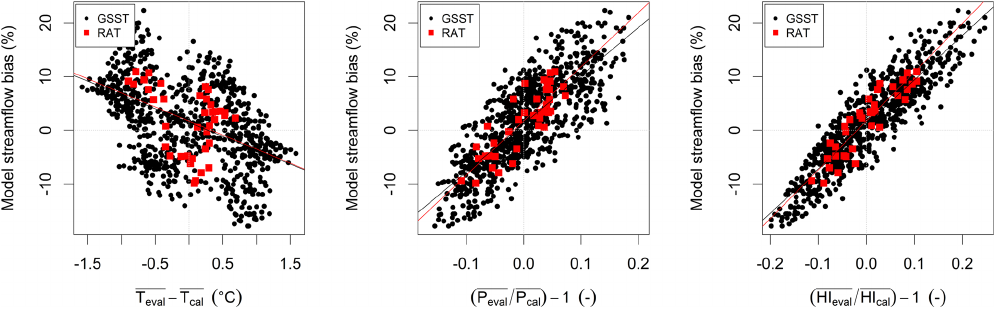
Figure 4. Streamflow bias obtained with the RAT (red squares) and the GSST (black dots), as a function of temperature, precipitation and humidity index anomalies, for the Orge River at Morsang-sur-Orge (H4252010) (934km 2 ).